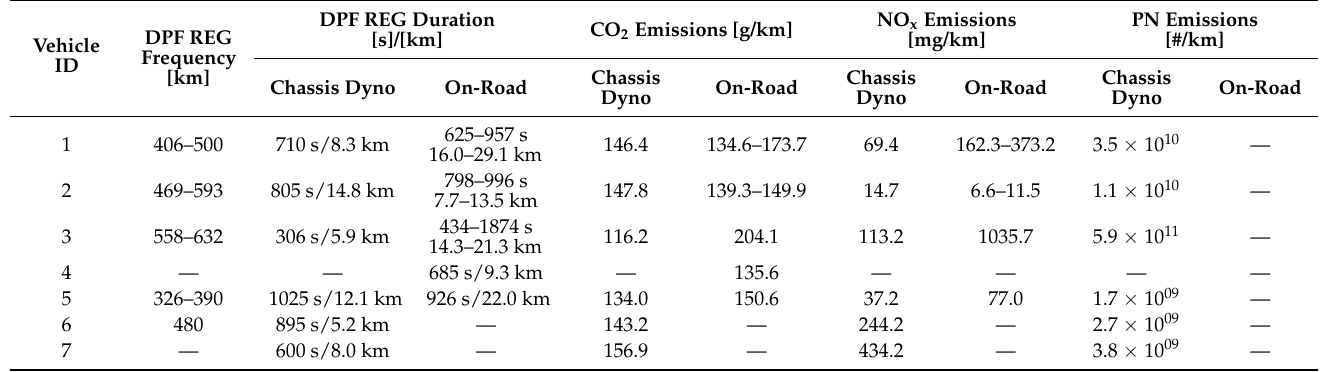
Table A6. Actual CO 2 , NO x and PN emissions of tests without DPF regeneration during the regener- ation phase of the equivalent